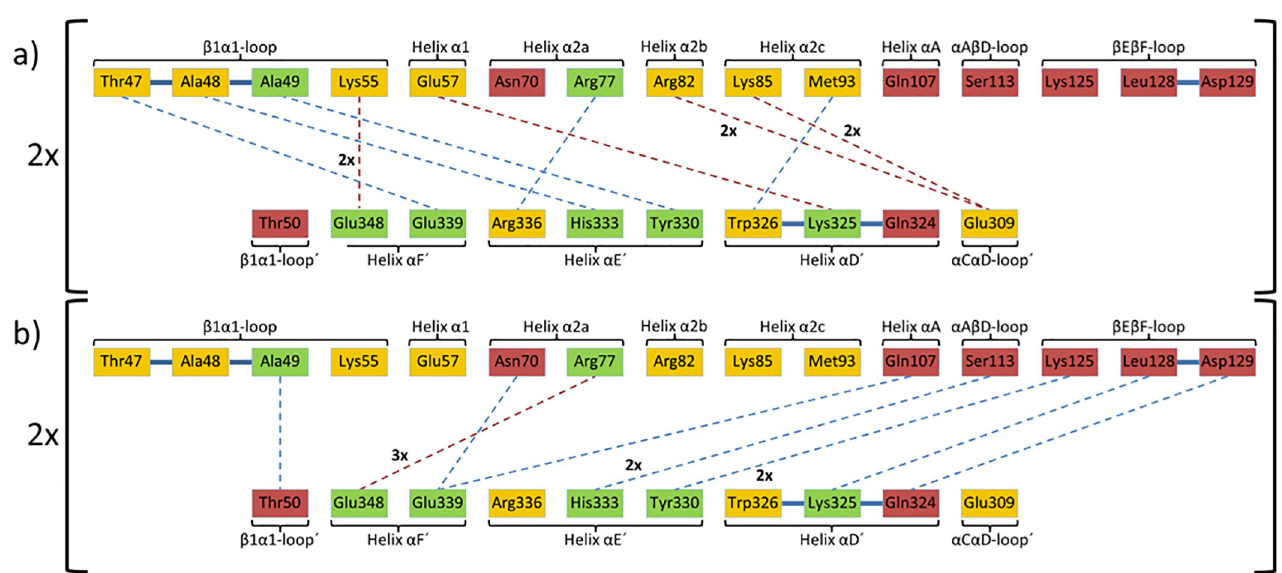
Fig 6. Polar interactions formed in a) apo-TGT (PDB entry: 1P0D [18]) and b) twisted dimer found in TGT (cid:1) 9 co . Residuesthat form H-bondsor salt bridges across the interface only in apo-TGT (yellow),in both structures (green), and in the twisted dimer (red) are indicated. Contacts were determinedby CONTACTSYM [47, 48]. Due to interface symmetry, all displayedinteractionsoccur twice but are depictedonly once for the sake of clarity. Only H-bonds(blue dashedlines) and salt bridges(red dashedlines) with distances between2.6 and 3.7 Å are depicted.